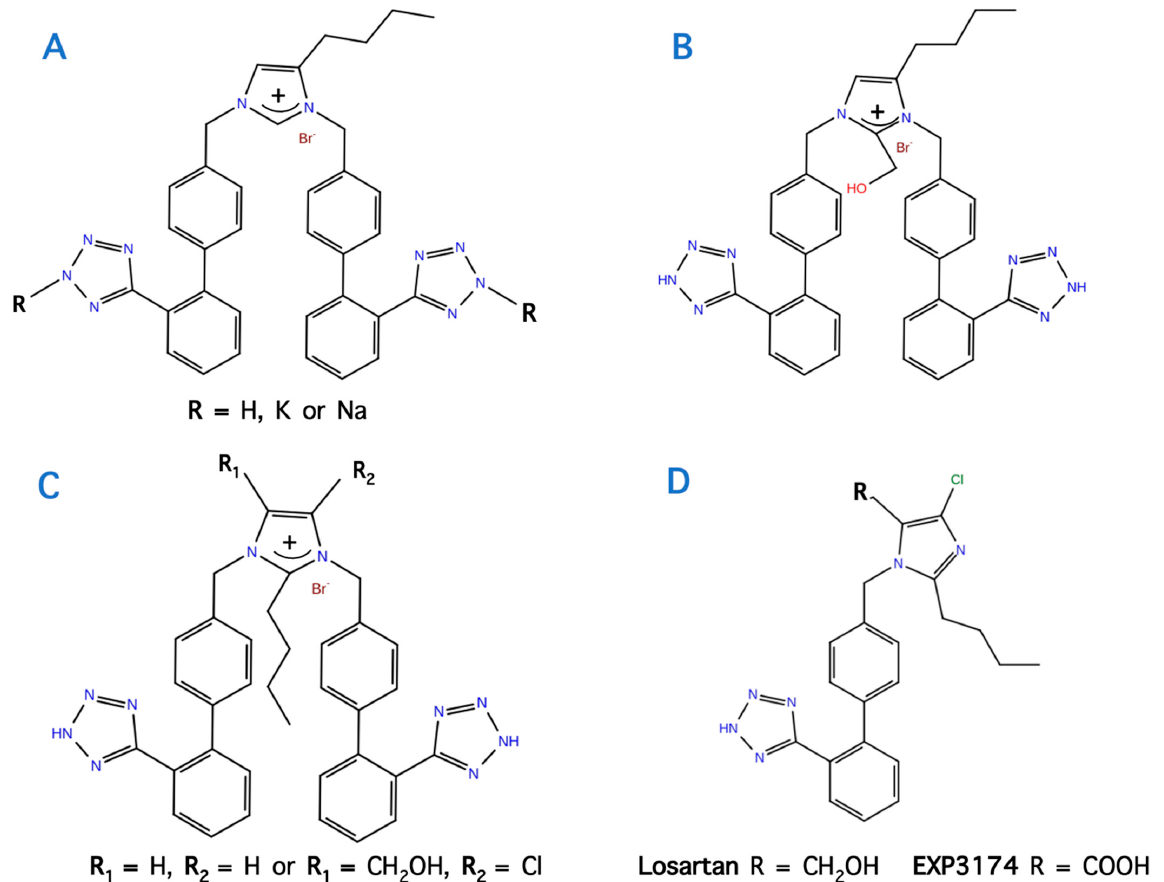
Figure 11. Bis biphenyl alkylation of the imidazole ring of losartan V8 (analogs A, B) and losartan (analog C) by a convenient and cost-effective strategy. Molecules 2019 , 24 , x FOR PEER REVIEW